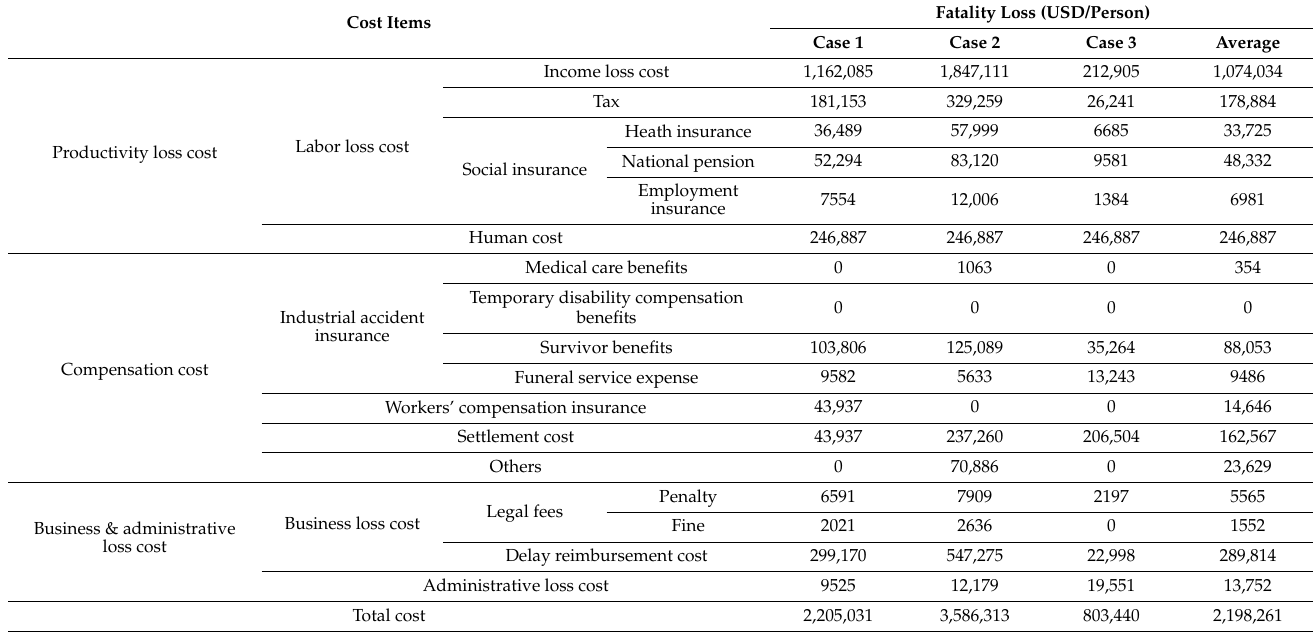
Figure 3. Total average of the fatality loss for 17 cost items. Table 7. Results of a case study on fatality